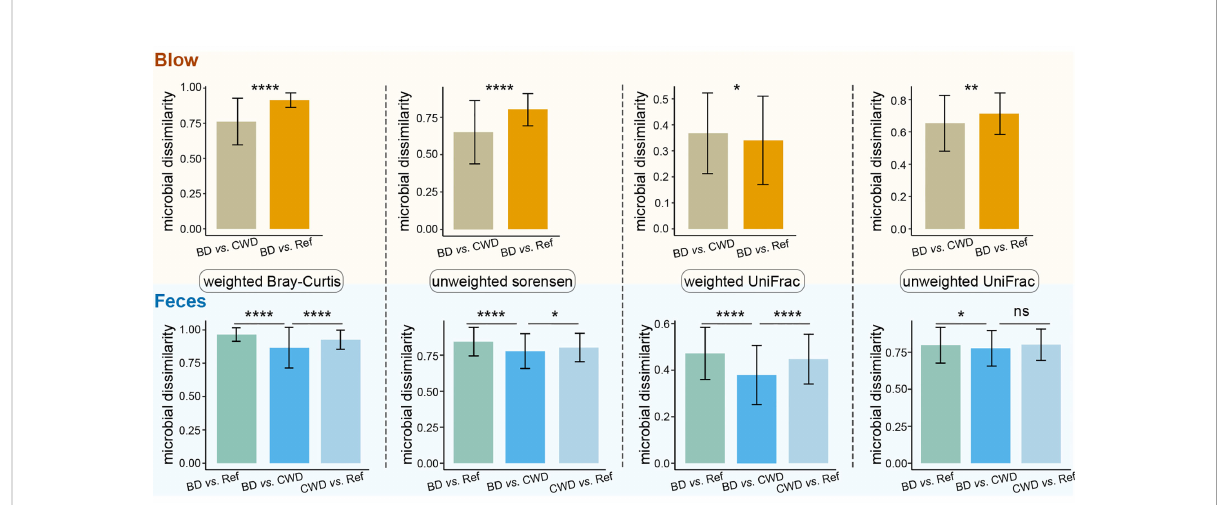
FIGURE 7 Information on within-group community dissimilarities for blow and fecal microbiotas. In these panels, higher microbial dissimilarity values indicate that these microbial samples are more dissimilar in composition. BD vs. CWD, the dissimilarity between bottlenose dolphins (BD) and the Chinese white dolphin (CWD). BD vs. Ref, the dissimilarity between bottlenose dolphins (BD) and the referred published datasets of their conspeci fi cs. CWD vs. Ref, the dissimilarity between the Chinese white dolphin (CWD)and the referred published datasets of their conspeci fi cs. Statistical signi fi cance is based on Wilcoxon rank sum test; **** P < 0.0001, ** P < 0.01, * P < 0.05. ns, not signi fi